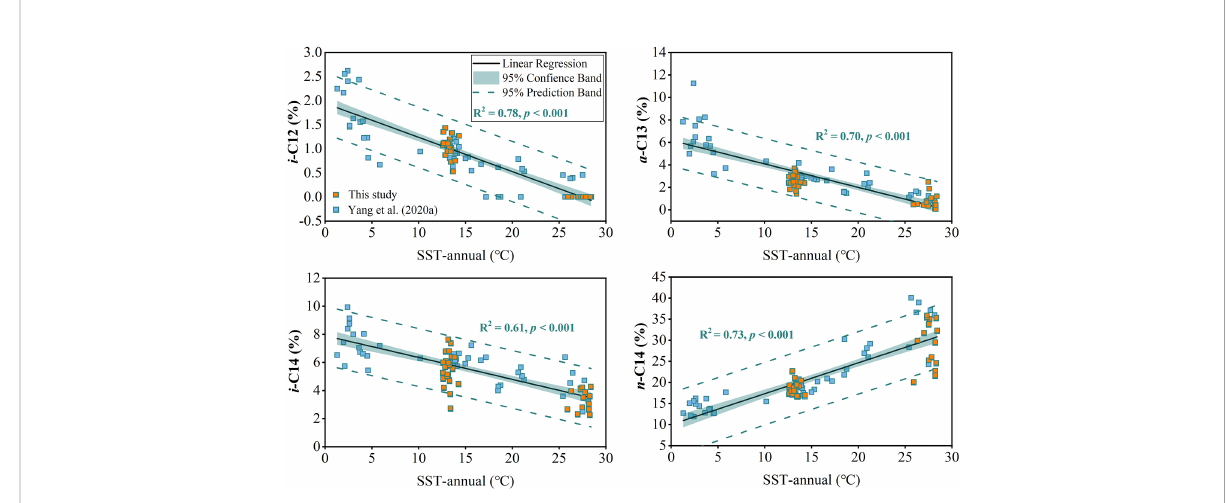
FIGURE 4 Cross plots showing the linear relationship between fractional abundance of 3-OH-FAs and annual mean